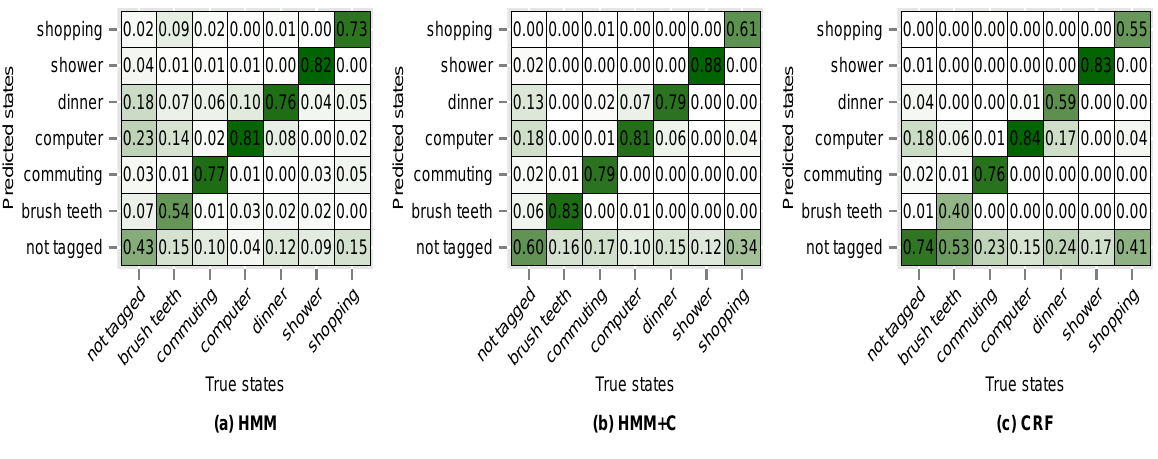
Figure 10. Confusion matrices for experiment 2 (subject 1): fixed subclassing.